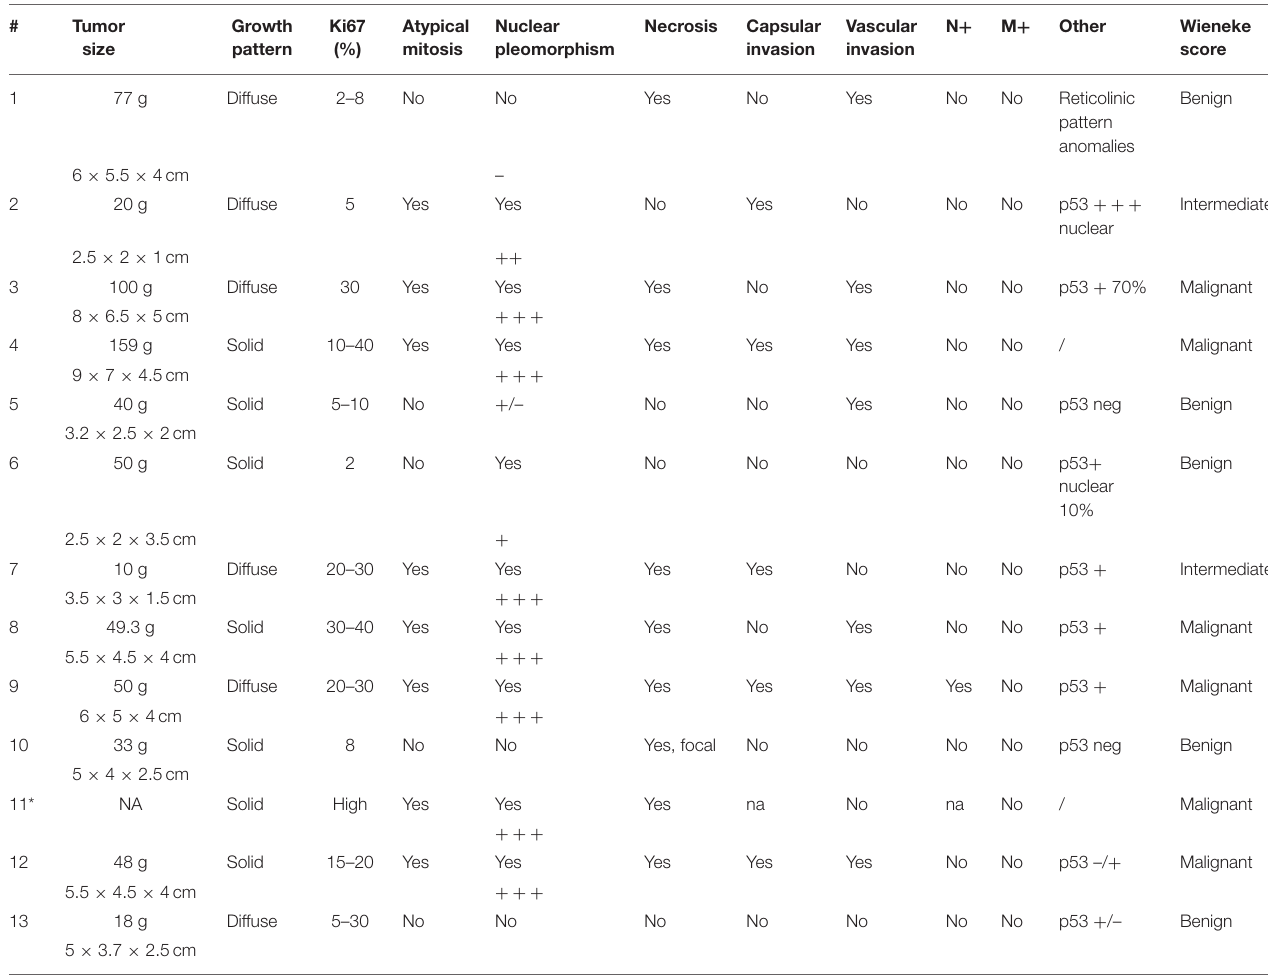
TABLE 3 | Pathological features in childhood